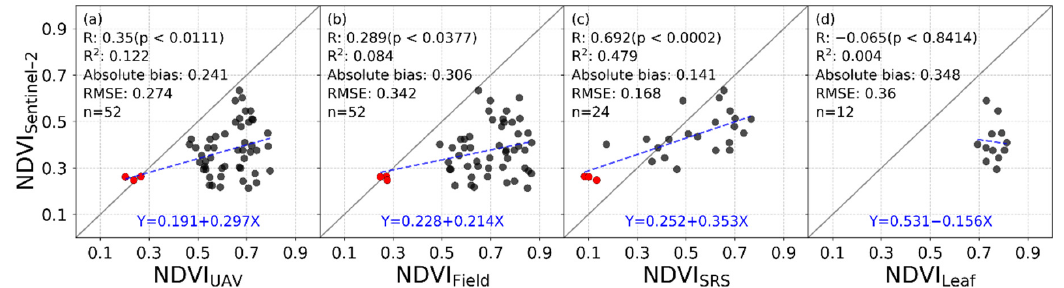
Figure 4. Relationship between NDVI Sentinel-2 and ( a ) NDVI UAV , ( b ) NDVI Field , ( c ) NDVI SRS , and ( d ) NDVI Leaf within the ROI. The blue dotted line refers to all data marked by circles. The red circles refer to the measurement data for the onion field on 28 March 2019.